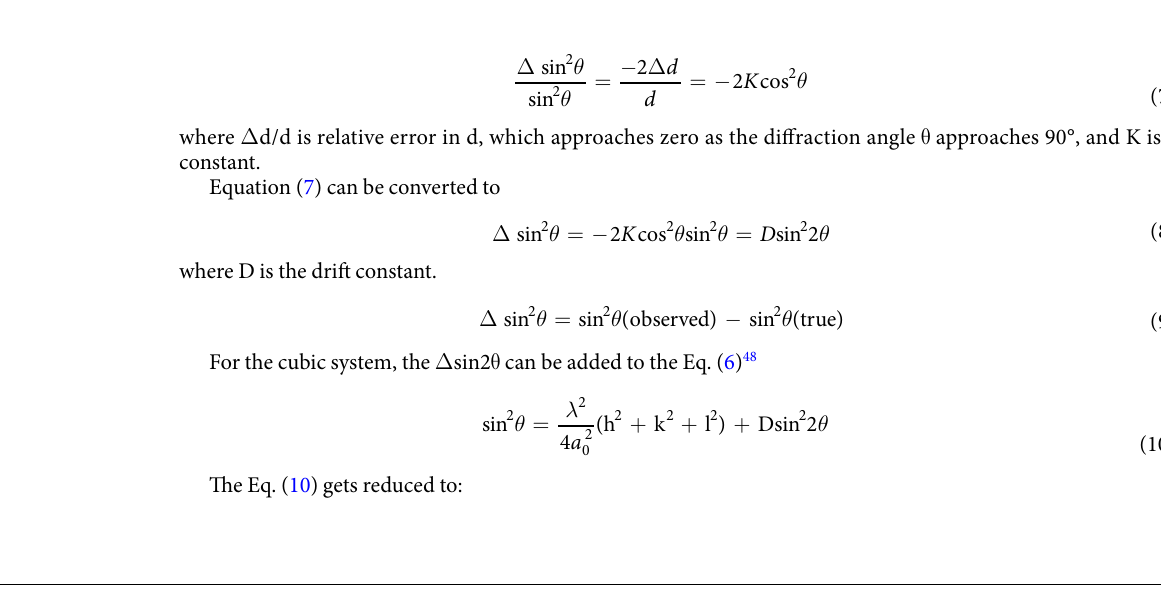
Figure 7. The TEM ( a – c ) and the corresponding SEAD ( d – f ) images and grain size distribution ( g – i ) of pure Cu, RGO/Cu-5 and RGO/Cu-7,